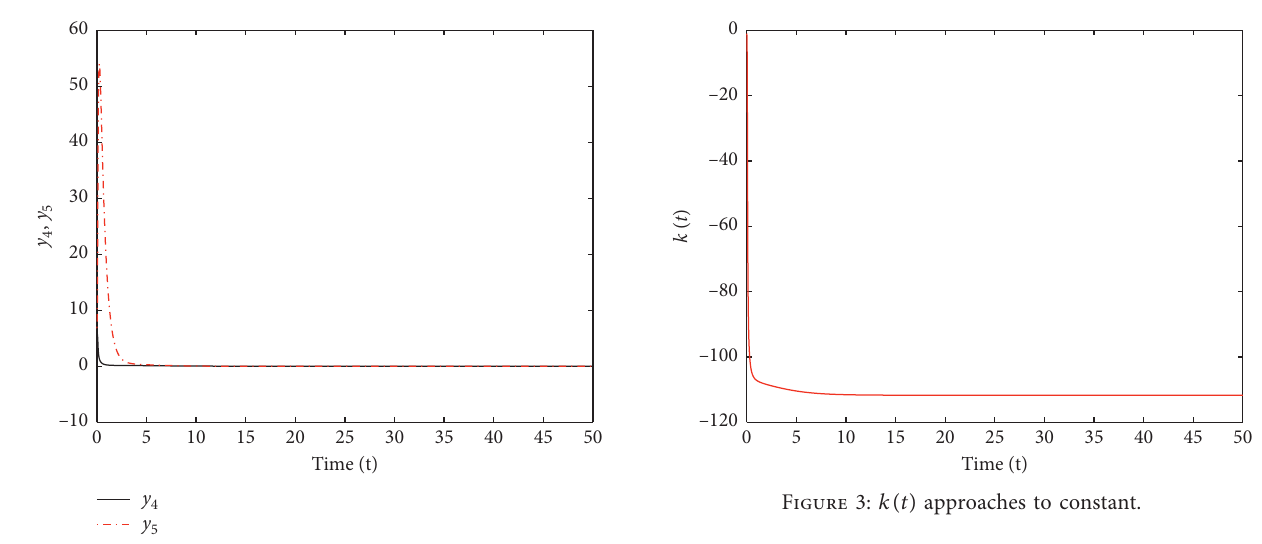
Figure 2: y and y are asymptotically stable. 4 5